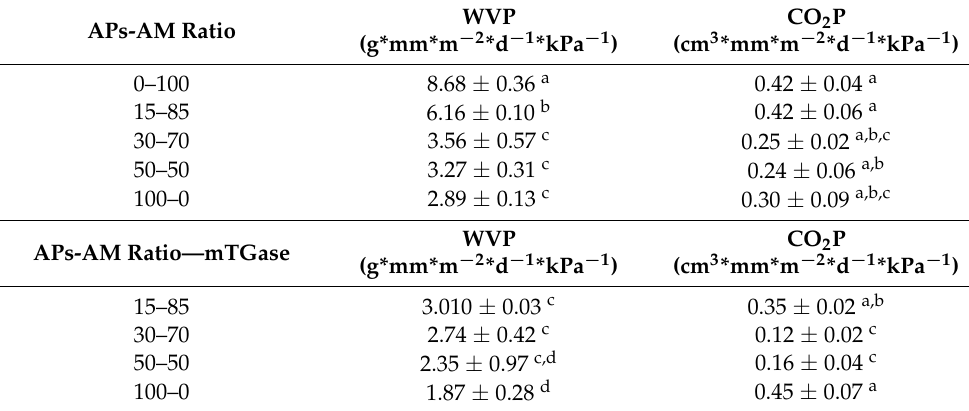
Table 3. Water vapor permeability and CO 2 permeability of films with different ratios of APs-AM treated or not with mTGase. Different small letters (a–d) indicate significant differences among the values reported in each column ( p < 0.05). The analysis was carried out in